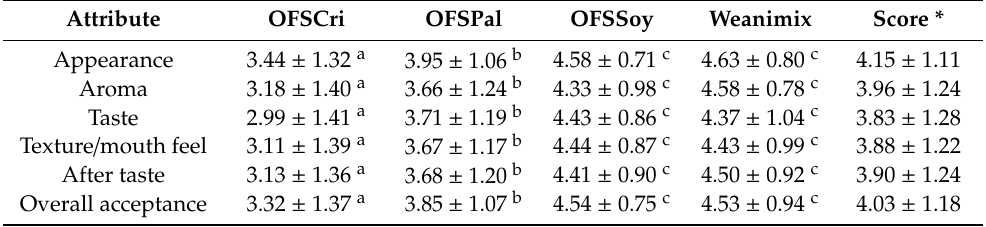
Table 5. Sensory evaluation of orange-fleshed sweet potato based complementary foods and Weanimix. Attribute